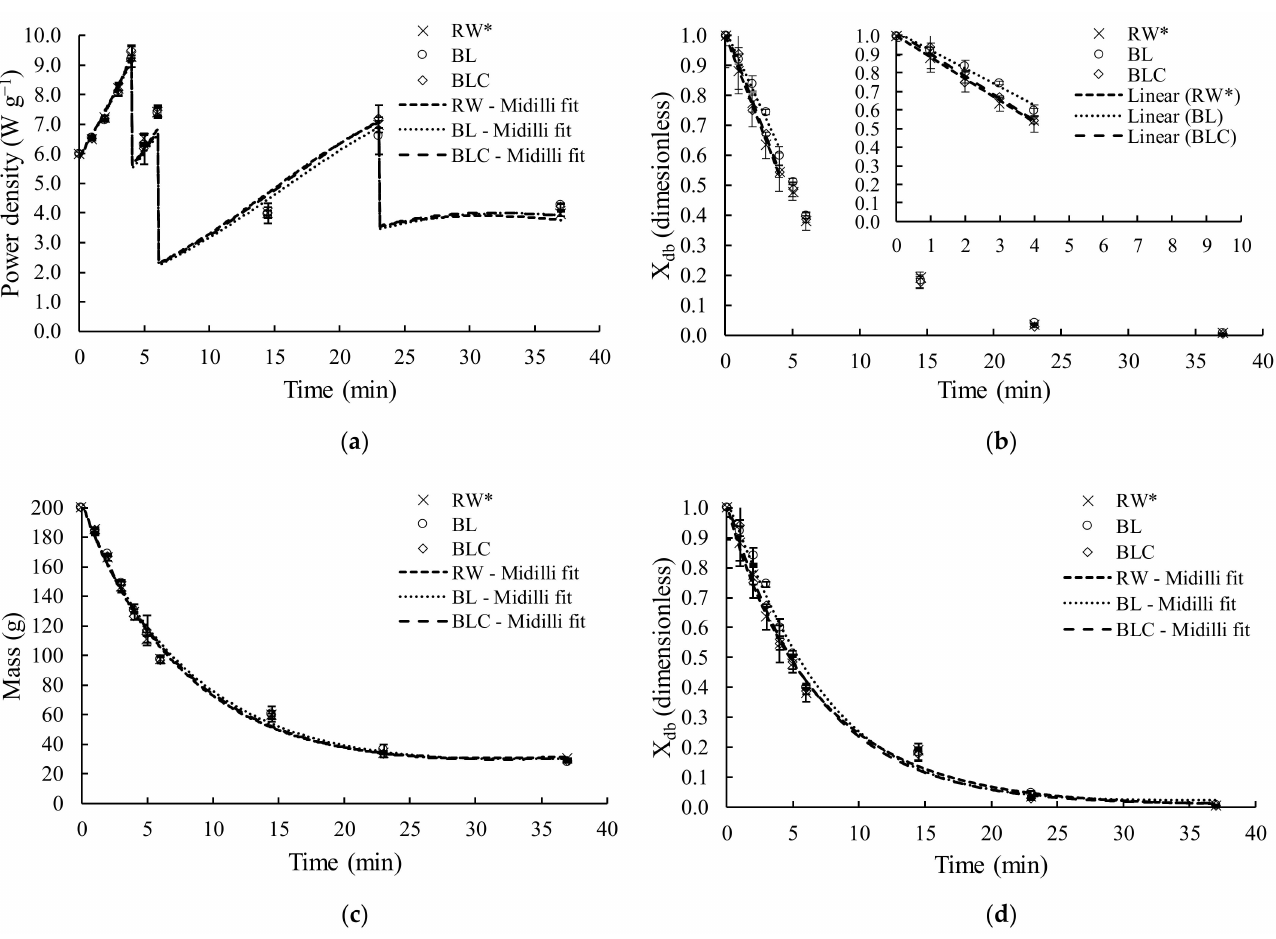
Figure 2. Temporal evolution of power density ( a ), constant drying rate period, represented by the straight line fit ( b ), the temporal evolution of mass ( c ), and temporal evolution of dimensionless moisture ( d ). Midilli model showed the goodness of fit (R 2 > 0.9). * Data from Gomide et al.